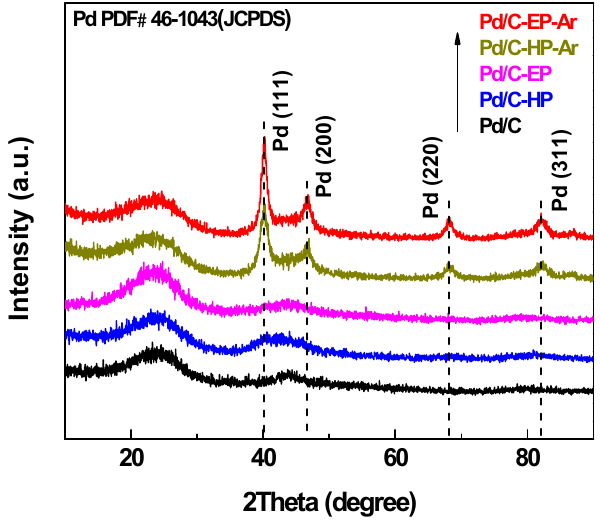
Figure 3. X-ray diffraction (XRD) patterns of Pd/C-EP-Ar, Pd/C-HP-Ar, Pd/C-EP, Pd/C-HP, and Pd/C.